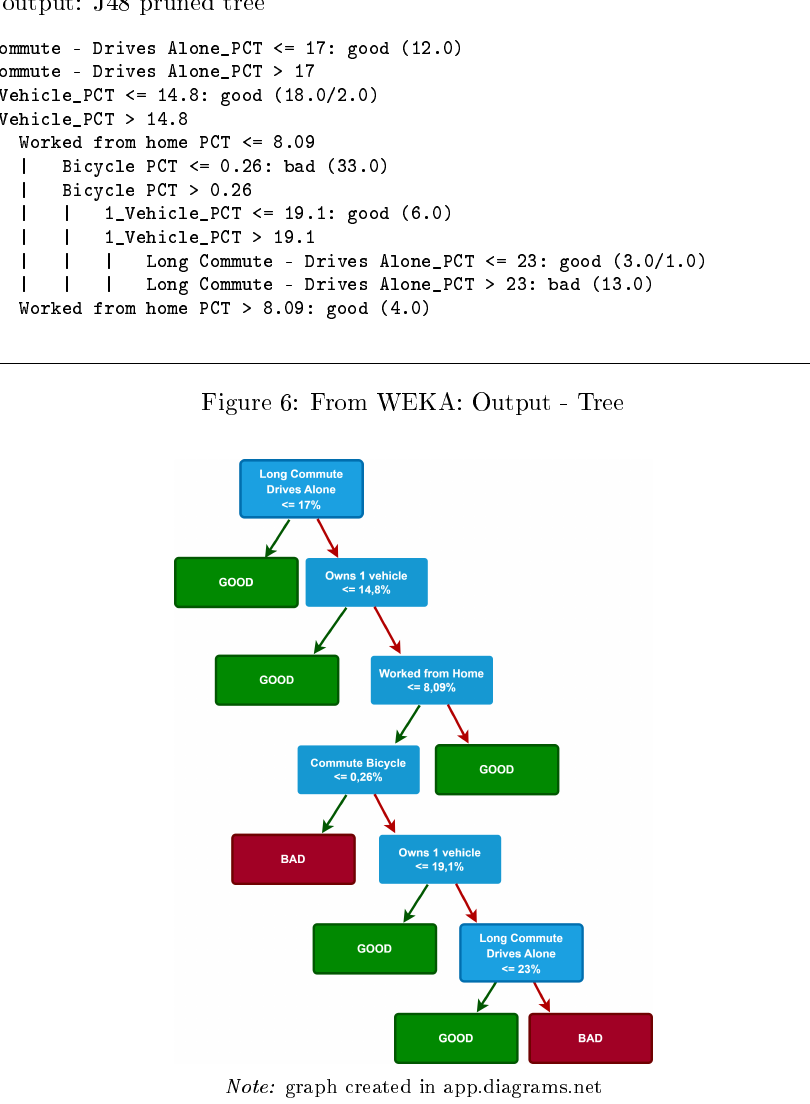
Figure 7: Decision